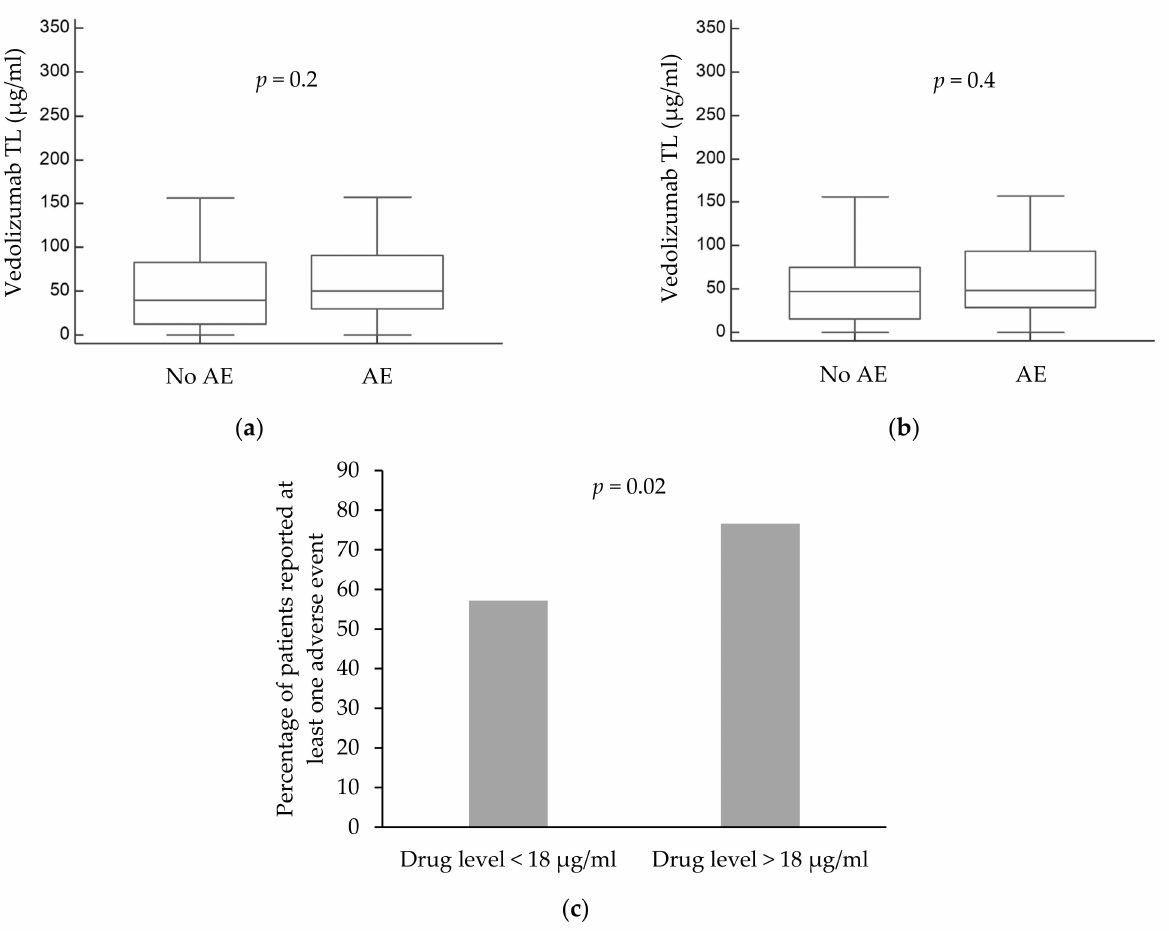
Figure 2. Association between vedolizumab serum drug levels and the reporting of adverse events (AEs). ( a ) Association between vedolizumab levels and reporting of at least one AE. ( b ) Association between vedolizumab levels and reporting of at least one AE, excluding fatigue and abdominal pain. ( c ) Association between vedolizumab trough levels of below or above 18 µ g/mL and reporting of at least one AE. Abbreviations: AE = adverse event; and TL = trough